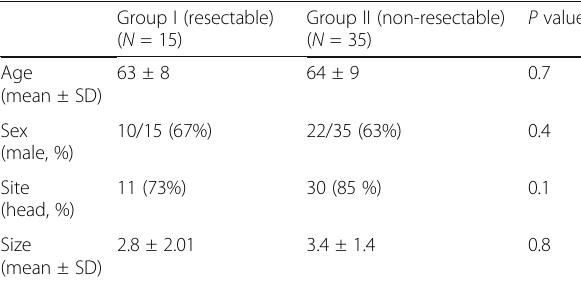
Table 1 Descriptive and imaging characteristics of studied patients